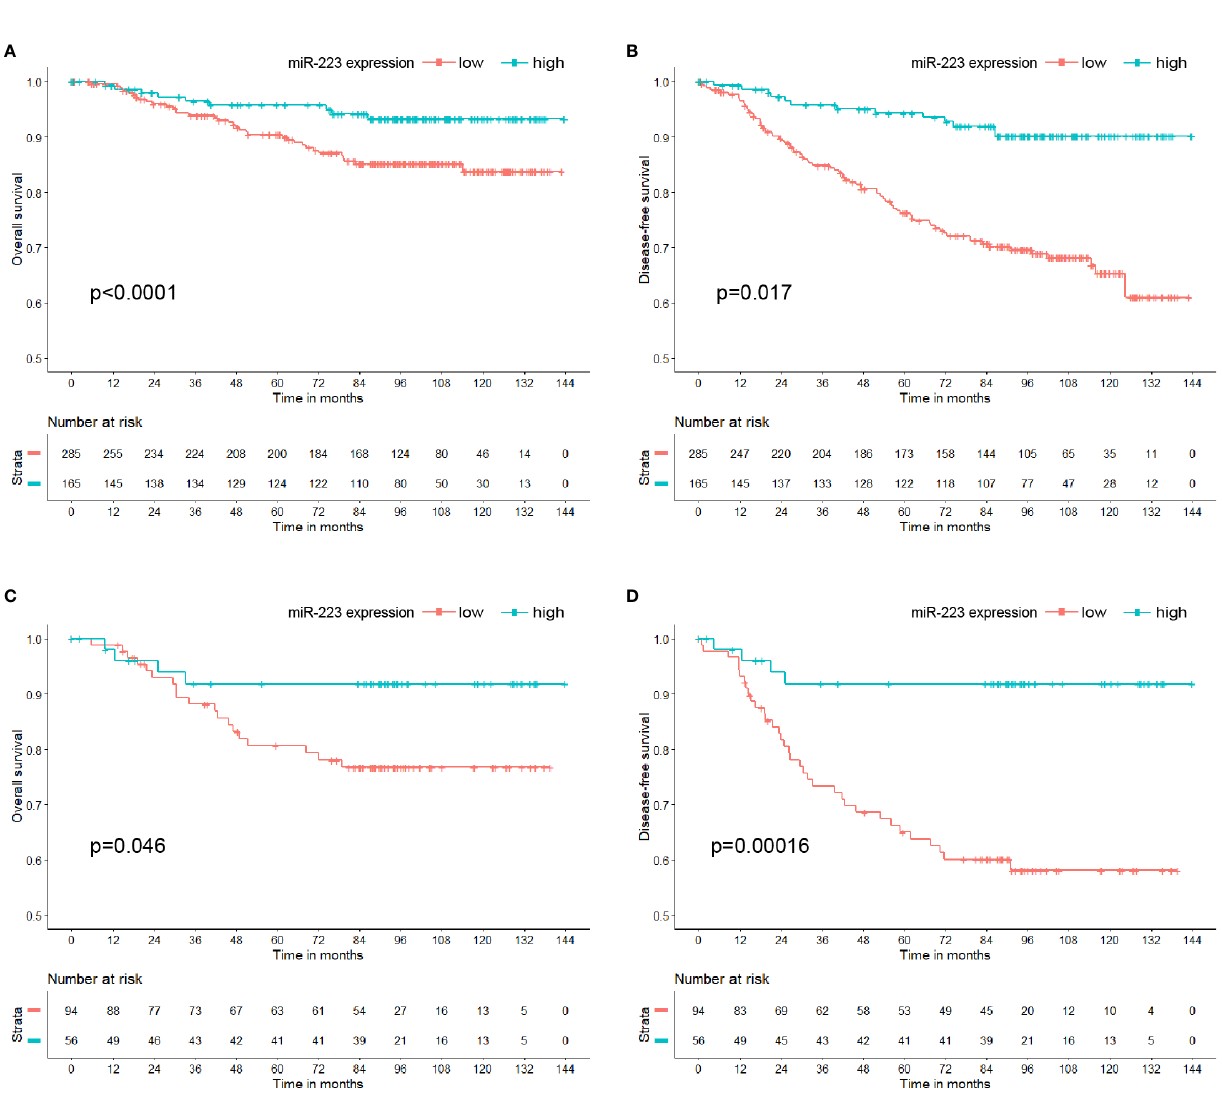
FIGURE 2 | Kaplan-Meier curve of miR-223 expression in breast cancer patients. (A) Overall survival in breast cancer patients; (B) disease-free survival in breast cancer patients; (C) overall survival in triple-negative breast cancer patients; (D) disease-free survival in triple-negative breast cancer